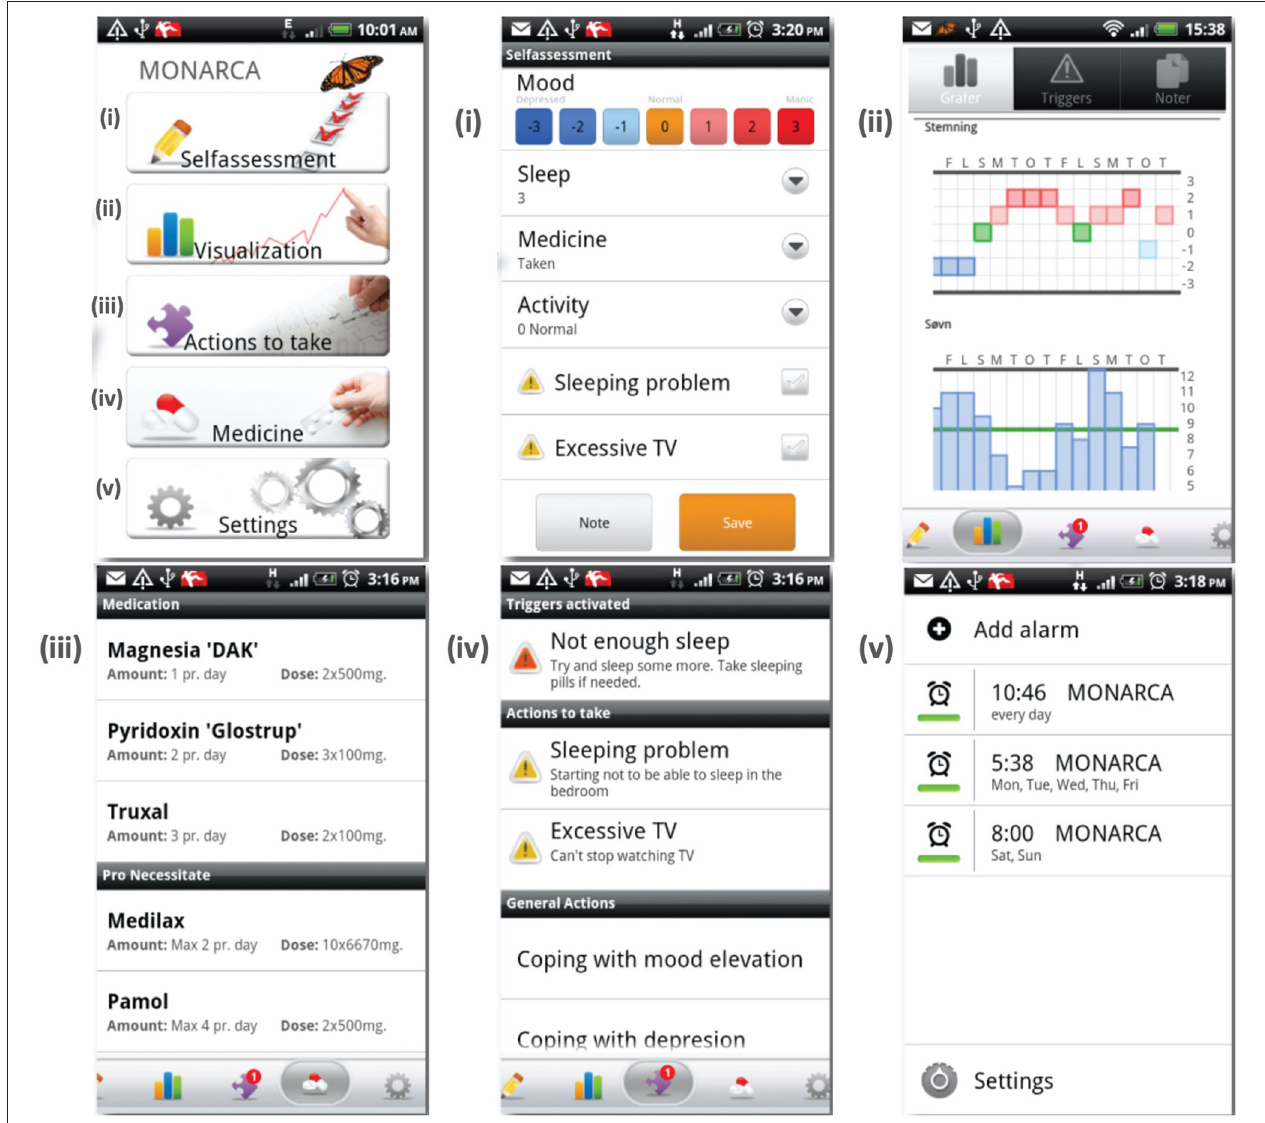
FIGURE 9 | The MONARCA application user interface [Modified from Bardram et al., 2013 (99)].